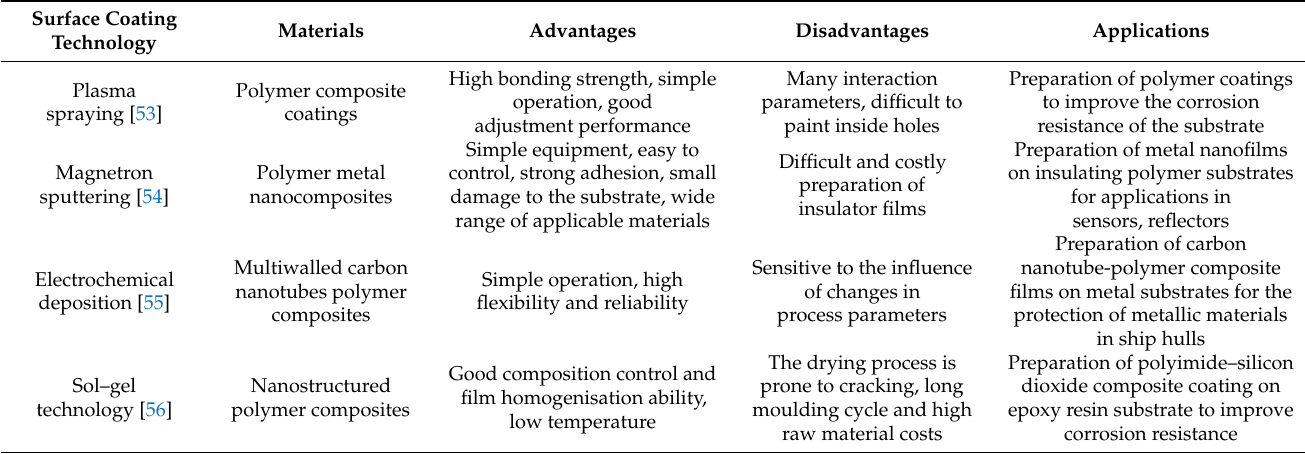
Table 4. Characteristics of various coating